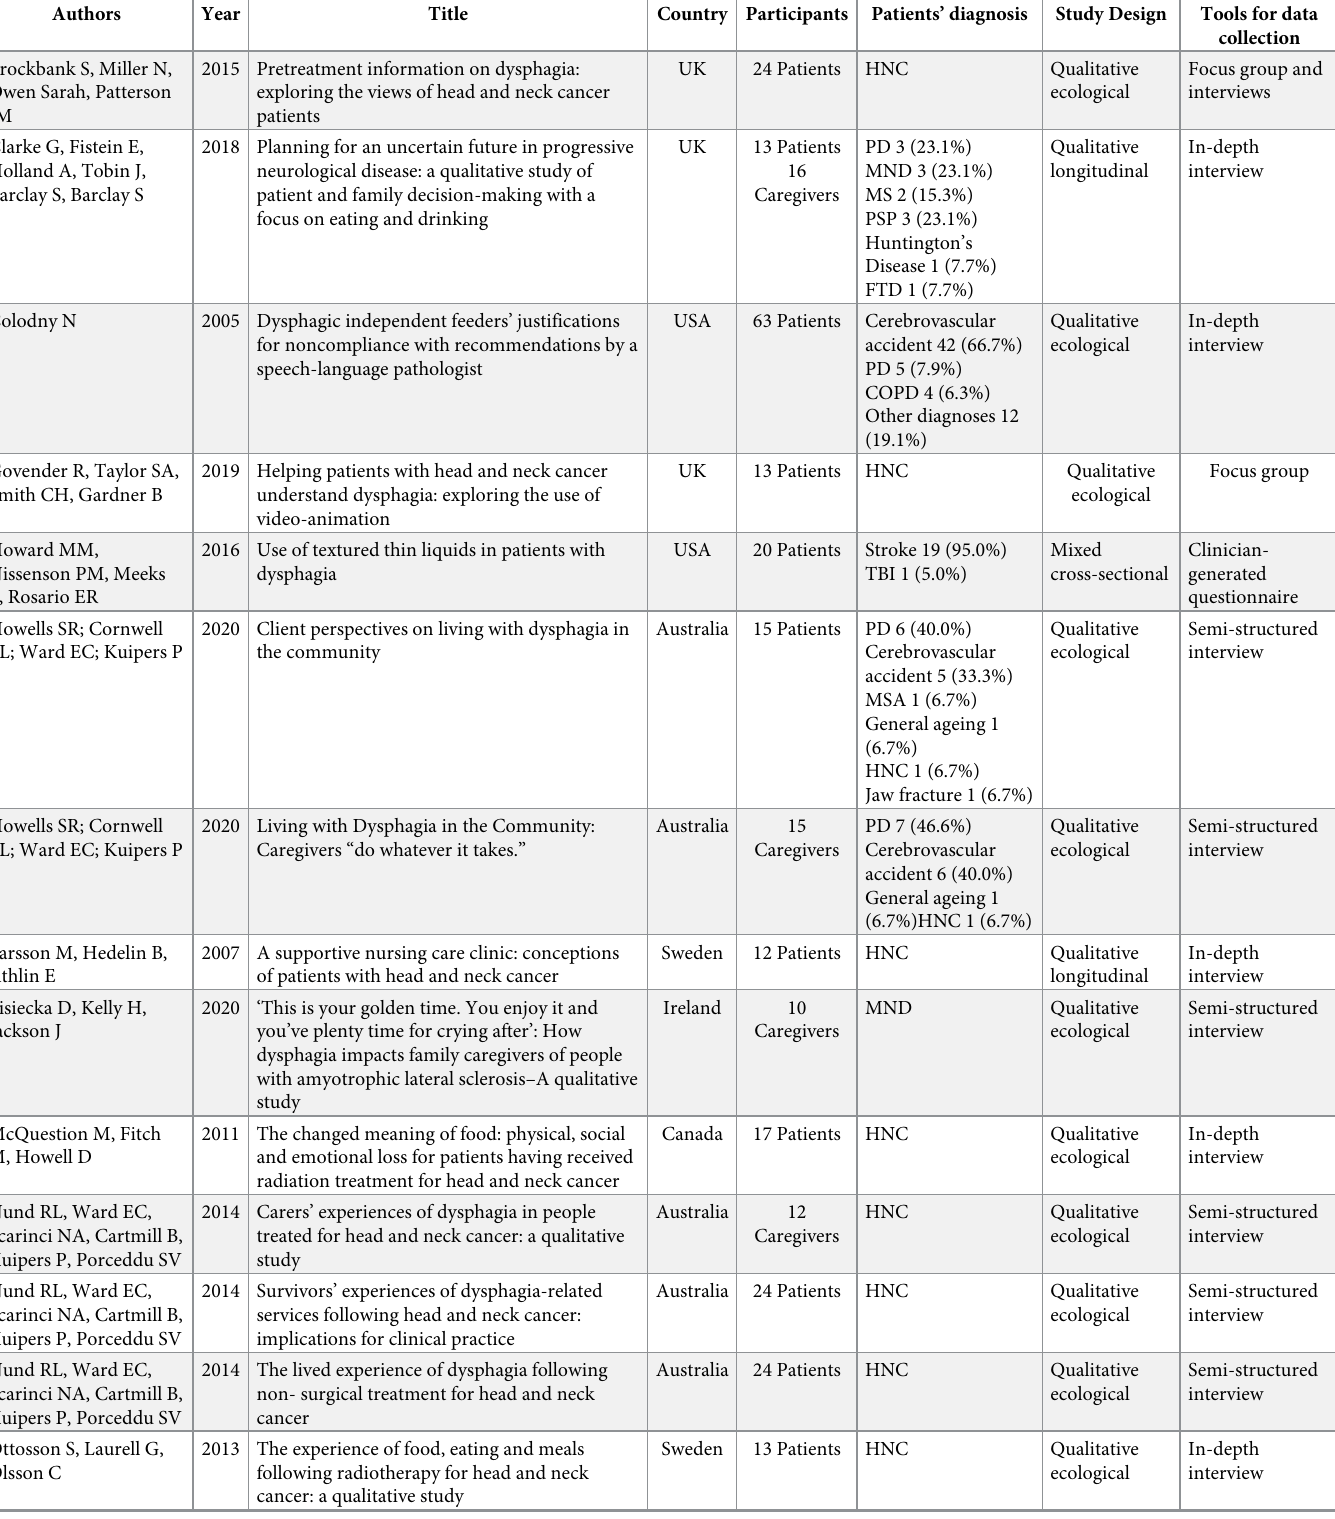
Table 1. Characteristics of the included